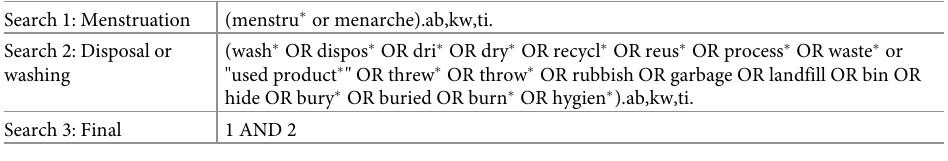
Table 1. Scopus search